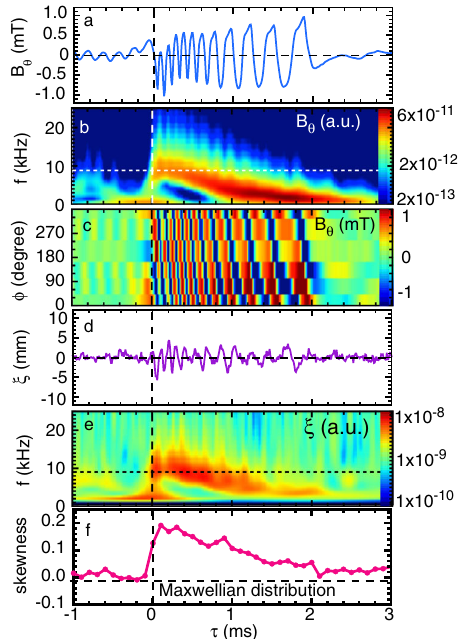
Fig. 2 Characteristics of Landau damping. Time evolution of a magnetic fi eld perturbation, b frequency spectrum power of magnetic fi eld perturbation, c contour of magnetic fi eld perturbation, d plasma displacement at r eff / a 99 = 0.83 evaluated from perturbation of electron temperature, e frequency spectrum power of plasma displacement, and f skewness of ion velocity distribution function at r eff / a 99 = 0.79 with conditional averaging with respect to the collapse time of energetic ions, as indicated by the sharp increase in radio frequency (RF) intensity, plotted in Fig. 1d. (#164992, #165851, #165859, #165862, #165863, #165943, #165971,